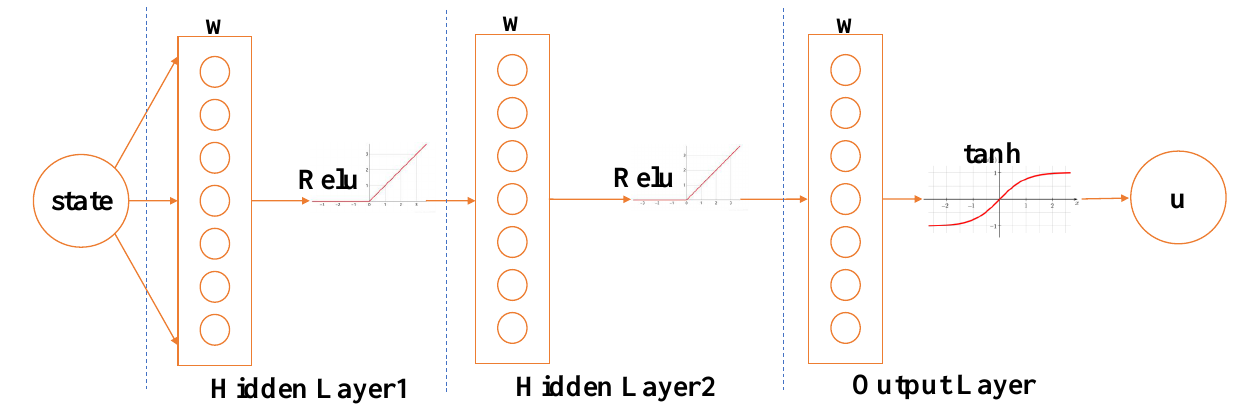
Figure 4. The structure of the policy network, which consists of three layers: the hidden layer action unit is Relu, and the output layer action unit is tanh.